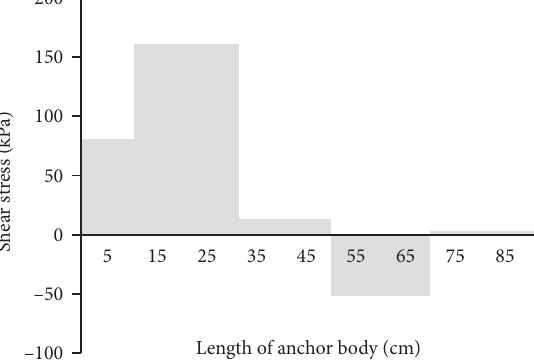
Figure 14: Shear stress distribution of anchor 90cm.